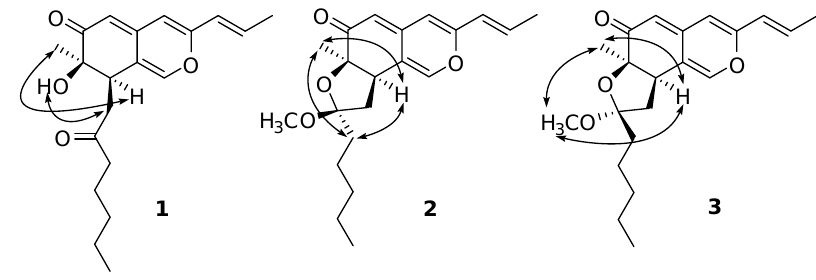
Figure 3. Key NOESY correlations of compounds 1 - 3 .